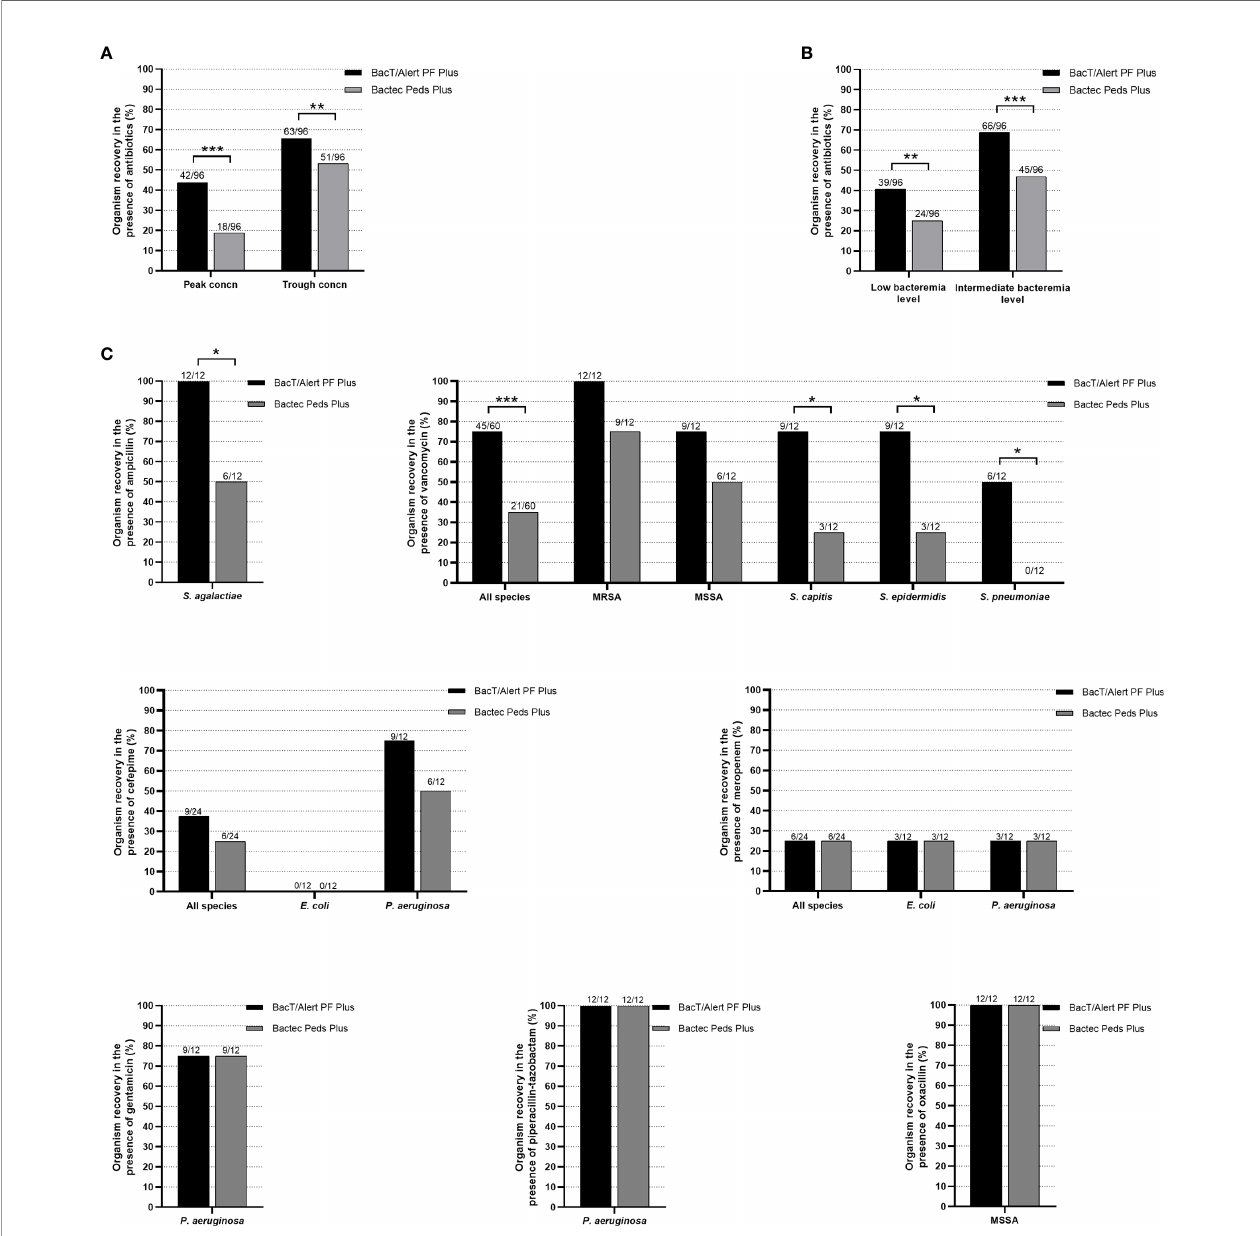
FIGURE 1 | Percentages of organism recovery from BacT/Alert PF Plus or Bactec Peds Plus BC bottles inoculated with antibiotic-containing blood as strati fi ed by antibiotics peak or trough concentrations (A) , low or intermediate bacteremia levels (B) , and antibiotic – organism combinations (C) , respectively. Percentages are relative to the organism recovery from the total of antibiotic-containing BC bottles inoculated for each indicated group. All (100%) of BC bottles without antibiotics used as controls yielded organism recovery (data not shown). Asterisks indicate the statistical signi fi cance of comparisons between BC bottles (* P = 0.01; ** P < 0.001; *** P < 0.0001). Comparisons with P values of >0.05 were not